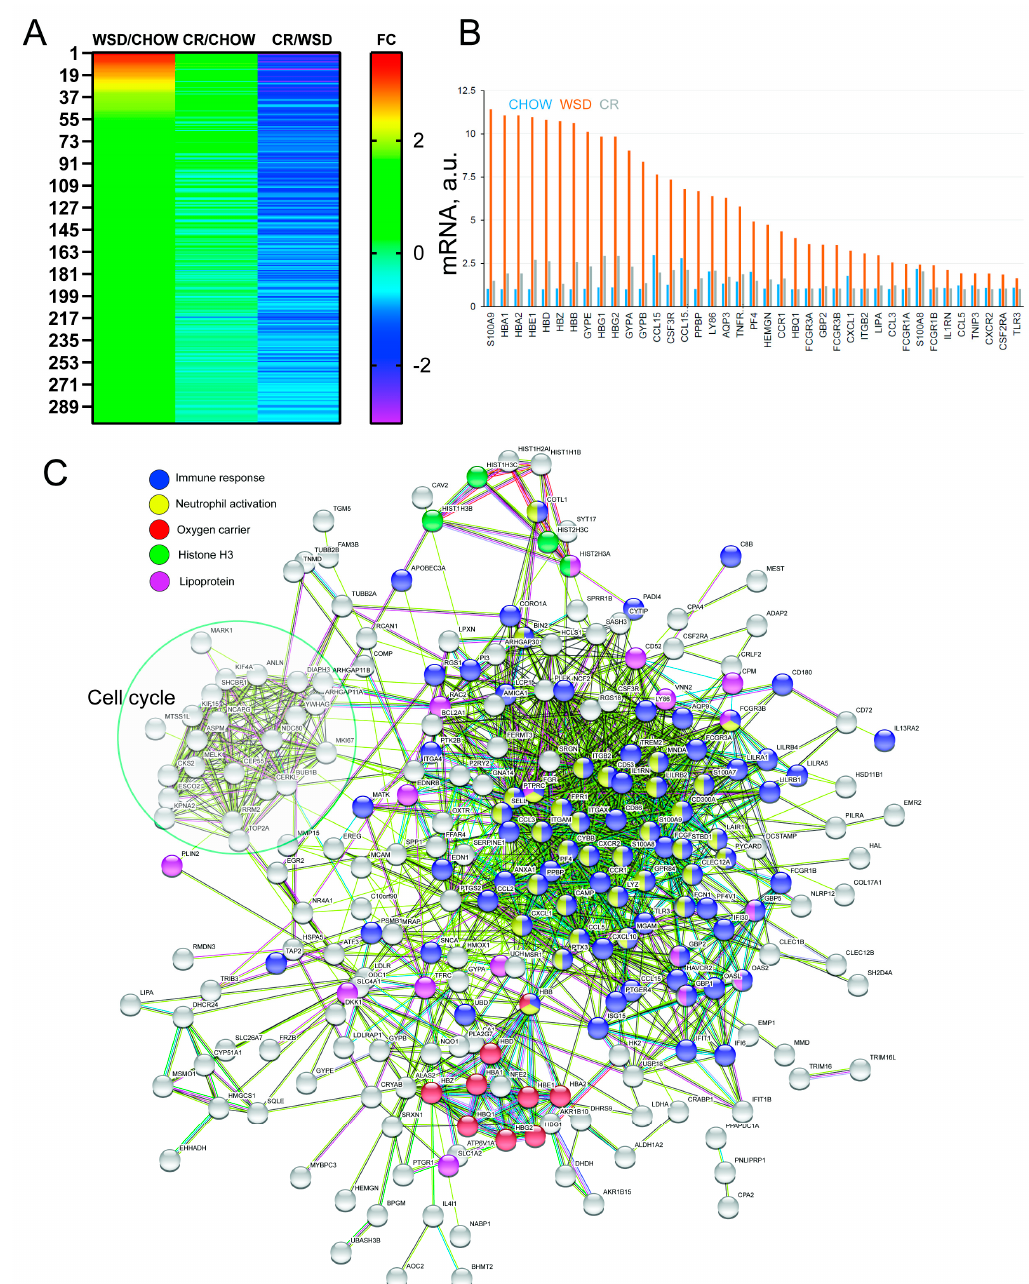
Figure 2. Western-style diet ( WSD) induces and caloric restriction (CR) reverses pro-inflammatory gene expression in subcutaneous white adipose tissue (SC-WAT). Three SC-WAT biopsies collected at the end of each dietary period were subjected to the RNA-Seq transcriptional analysis. This figure describes only reversibly-induced differentially expressed genes (DEGs) that were significantly upregulated by WSD and then significantly downregulated by CR. ( A ) Heat map of DEGs (the number of genes is indicated); FC, log2fold changes in gene expression. ( B ) Top WSD-induced DEGs that were downregulated by CR; relative mRNA levels are shown in arbitrary units (a.u.). ( C ) STRING Functional Protein Network Analysis of DEGs reveals functional connectivity associated with immune response (blue), neutrophil activation (yellow), heme biosynthesis (red), histone H3 network (green), lipoprotein metabolism (magenta), and regulation of cell cycle progression